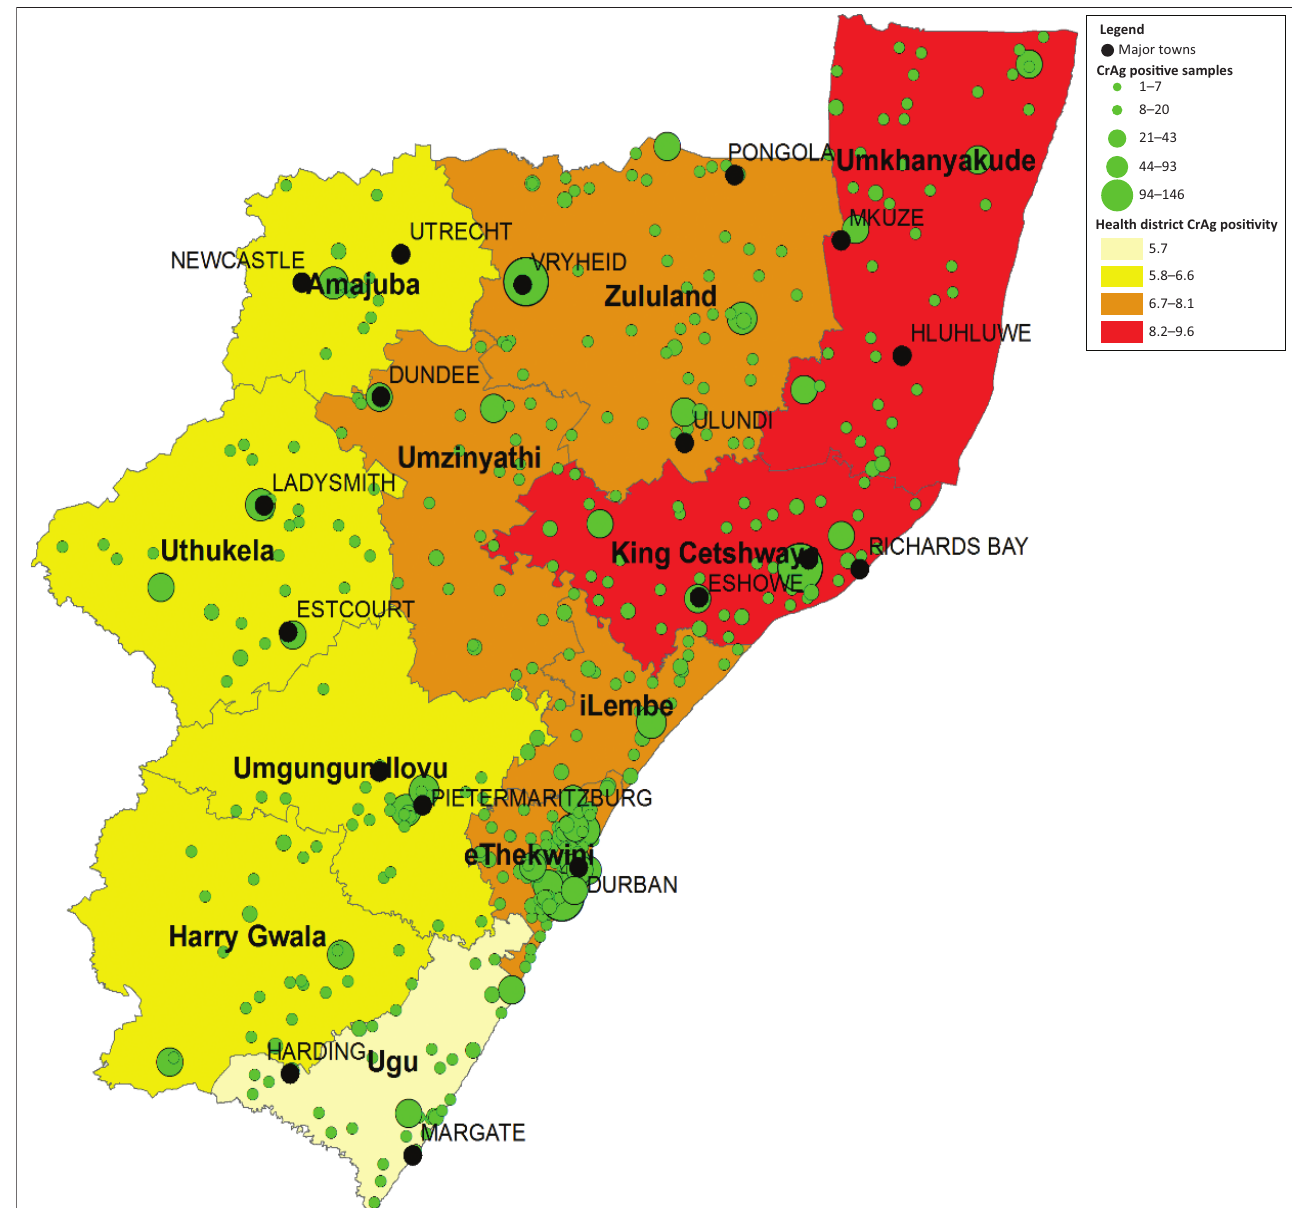
FIGURE 1: Spatial analysis of the number of positive CrAg samples by health facility reported across five